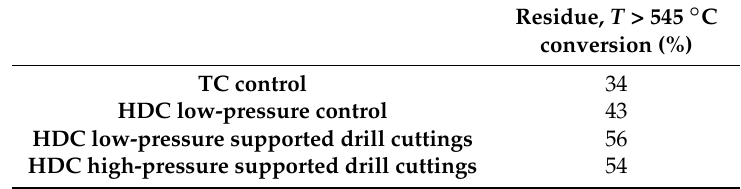
Table 5. Residue conversion for select samples, calculated using equation